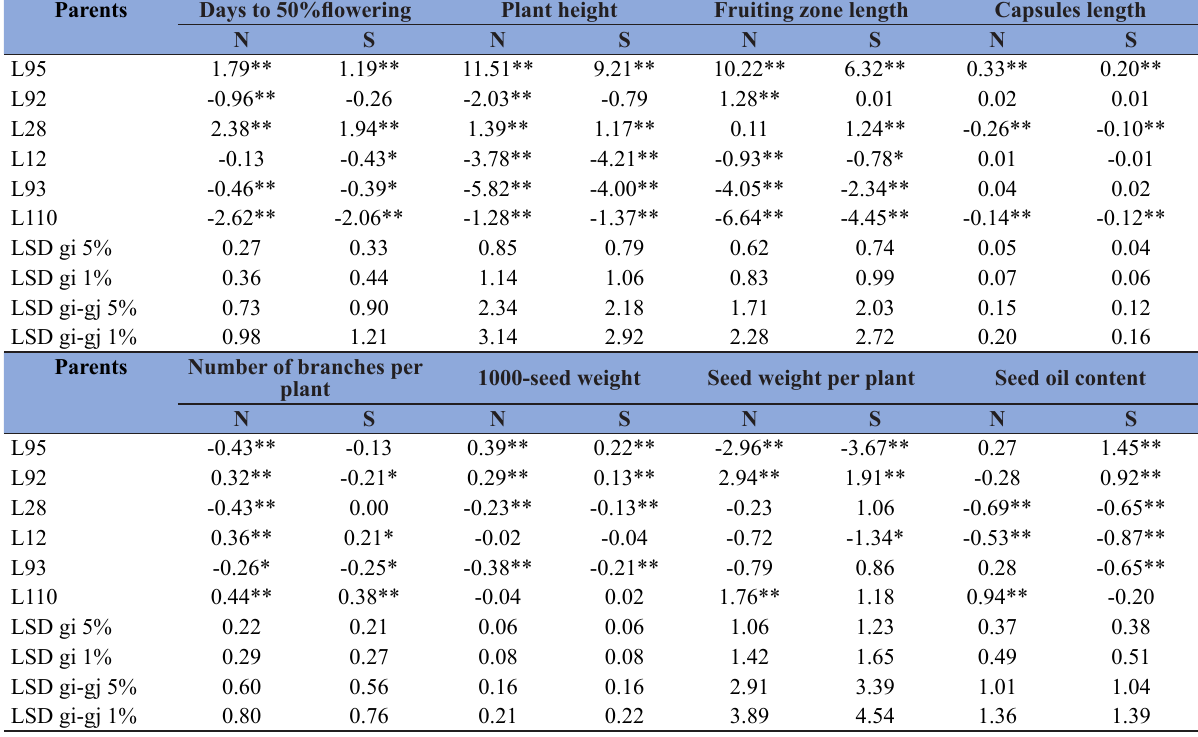
Table 8. General combining ability effects of six parental sesame genotypes for all studied traits under normal irrigation (N) and water stress conditions (S) in 2019 season